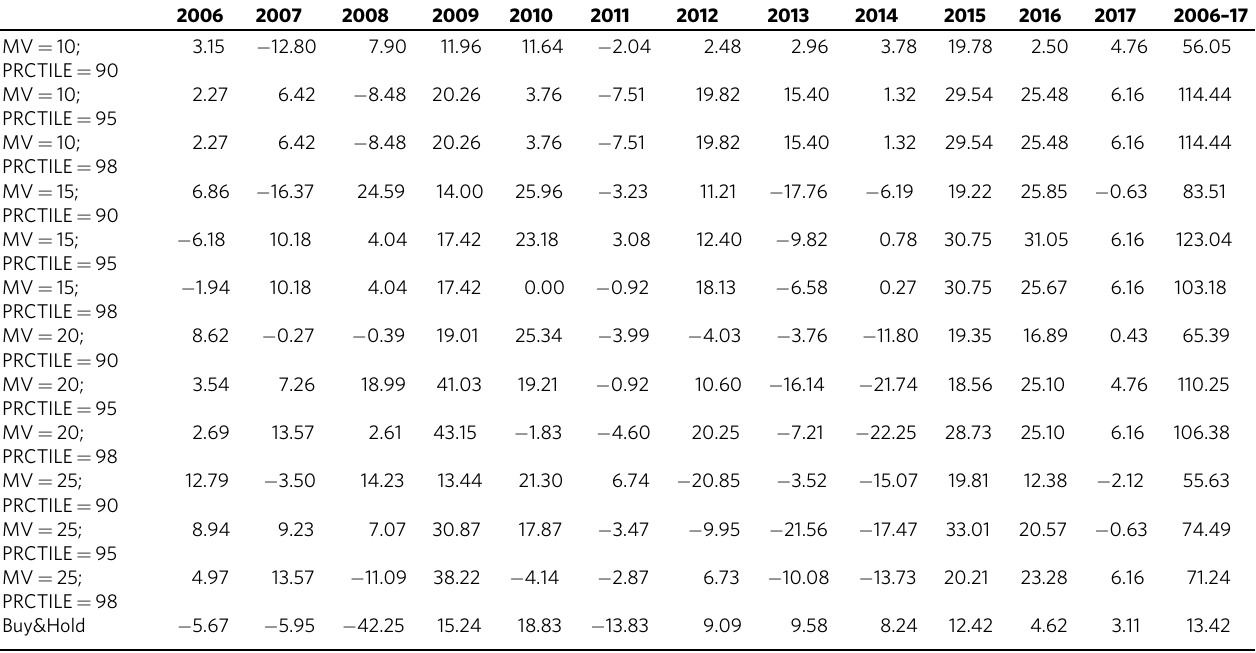
Table 1 Pro fi ts and Losses (P&L)